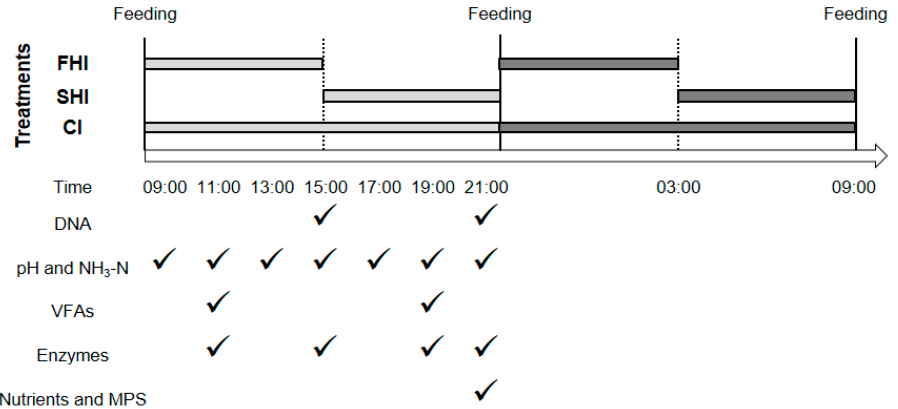
Figure 1. Schematic representation of treatment and sampling in this study. FHI treatment represents maltodextrin infusion from 09:00 to 15:00; SHI treatment represents maltodextrin infusion from 15:00 to 21:00; CI treatment represents maltodextrin infusion from 09:00 to 21:00. Light gray means infusion proceeded at daytime, and the dark gray means infusion proceeded at nighttime. Checkmark means sampling for corresponding items. FHI, first half infusion of maltodextrin; SHI, second half infusion of maltodextrin; CI, continuous infusion of maltodextrin; VFAs, volatile fatty acids; MPS, microbial protein synthesis.